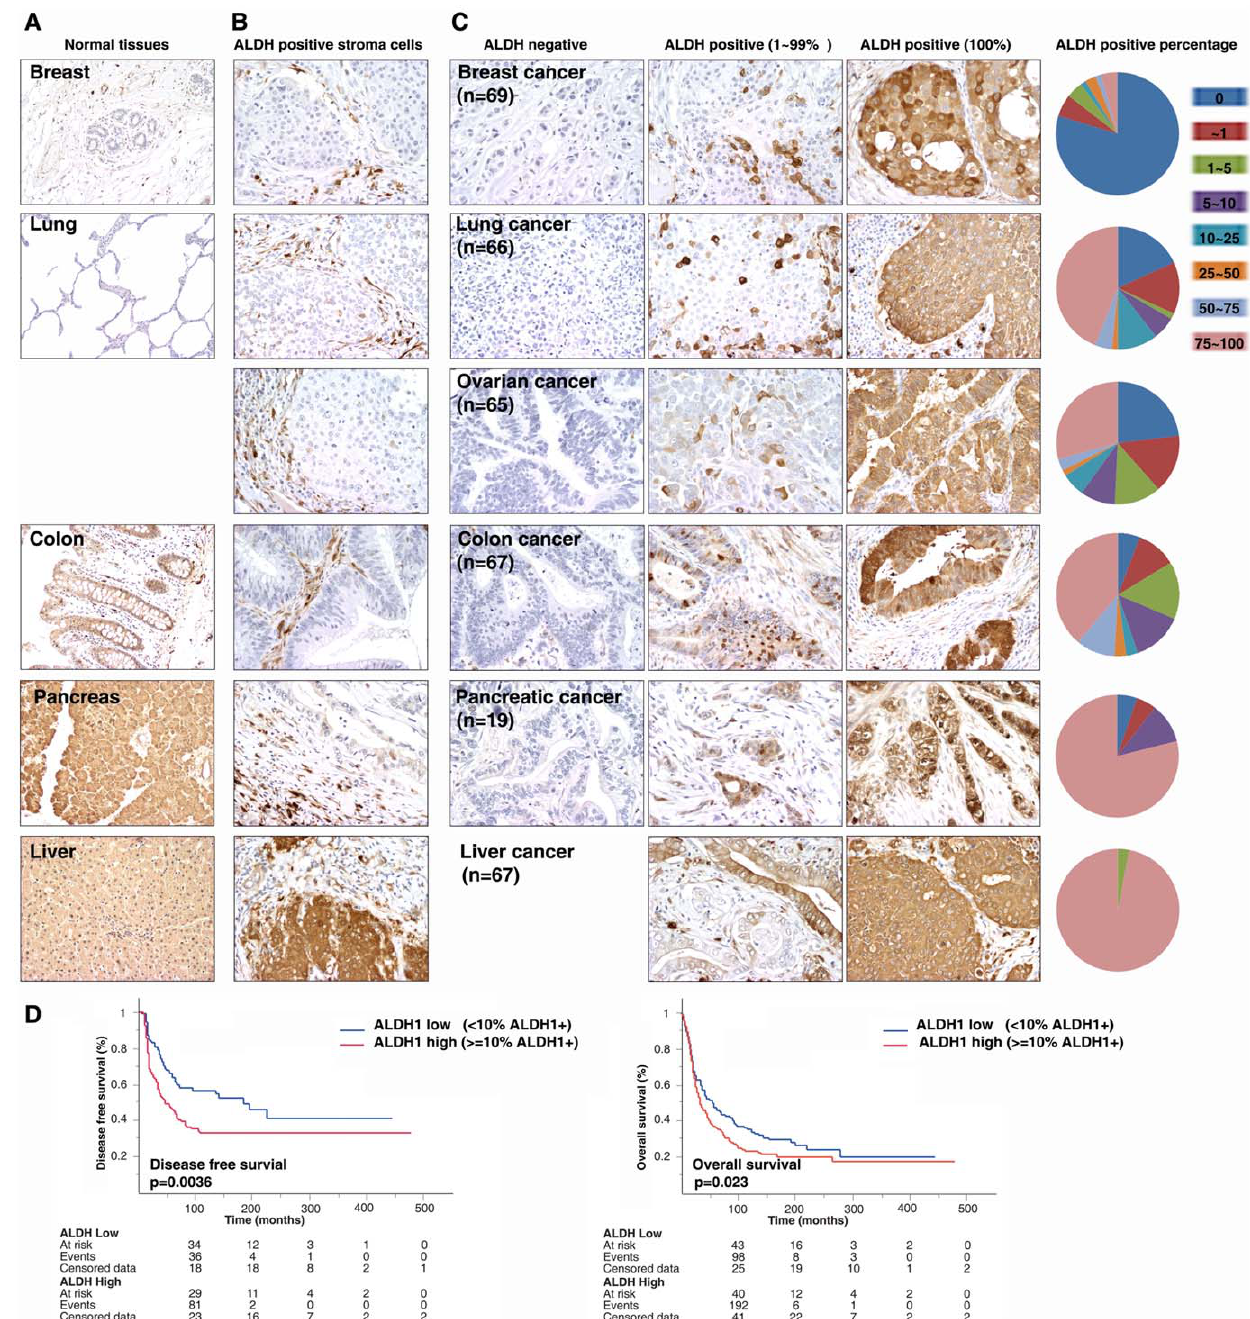
Figure 2. Expression and distribution of ALDH1 protein in human epithelial tumors. Tissue microarrays were used to characterize the expression and distribution of ALDH1 in cancers (n=353). A . Expression of ALDH1 in the corresponding normal tissues. B . ALDH1 + tumor-infiltrating cells were detected in the stroma. C . Expression of ALDH1 in epithelial tumors. Percentage of ALDH1 + tumor cells was summarized. D . High percentage of ALDH1 + cells was associated with poor clinical outcomes in serous ovarian cancer. doi:10.1371/journal.pone.0010277.g002 ALDH br cells was relatively higher in normal ovarian surface epithelial cells (human: 13.1 6 6.72%, n= 3; murine: 7.6%, n= 1) compared to ovarian cancer cells (human: 6.2 6 13.5%, n= 18; murine: 3.8 6 2.92%, Figure S2). Similarly, the percentage of ALDH br cells was relatively higher in normal mammary epithelial cells (8.18 6 4.31%, n =14) [34] compared to breast cancer cells (3.5 6 4.8%, n= 15, Figure 3).